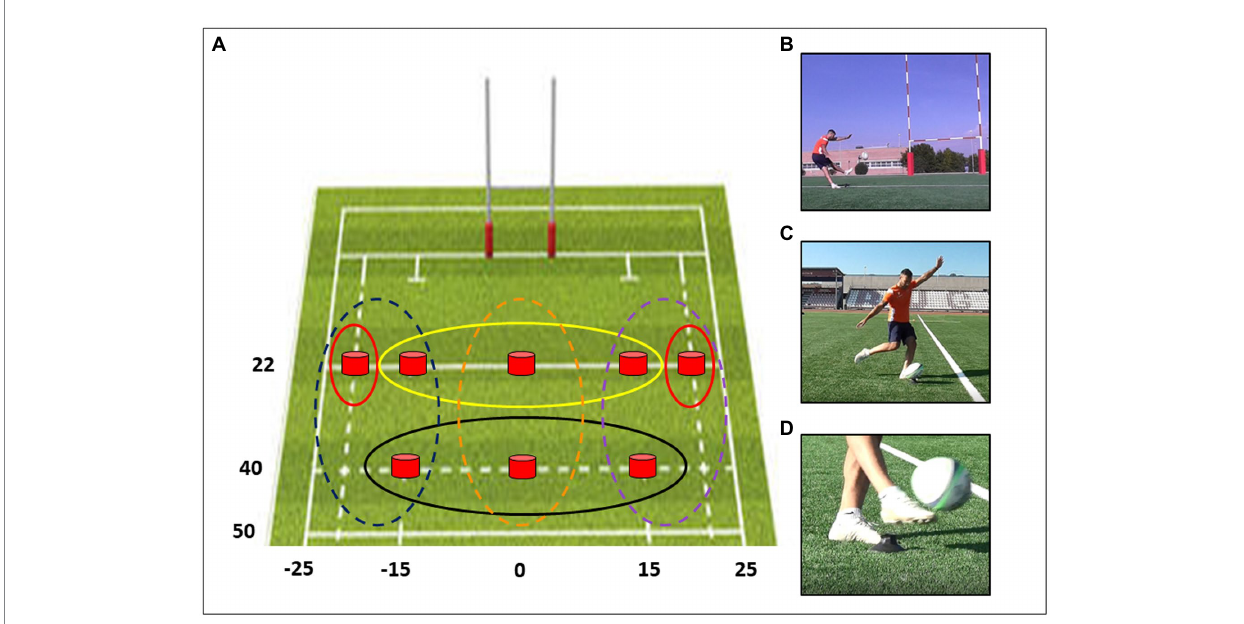
FIGURE 1 (A) shows a top view of the rugby mid-field, with the goalposts depicted on top. Numbers along the vertical and horizontal axes indicate in meters the distance of the kick positions from the goalposts line and the midline, respectively. Negative numbers refer to the left side of the court, and positive numbers to the right side, respectively. Red buttons indicate the eight positions from which placed kicks were executed. Red, yellow, and black circles refer to lateral, near, and distant zones. Blue, orange, and purple dotted circles refer to left-side, central and right-side positions on the court, respectively. (B–D) show the three perspectives from which a single placed kick was videotaped: back-view (B) , lateral (C) , and ball-only (D)